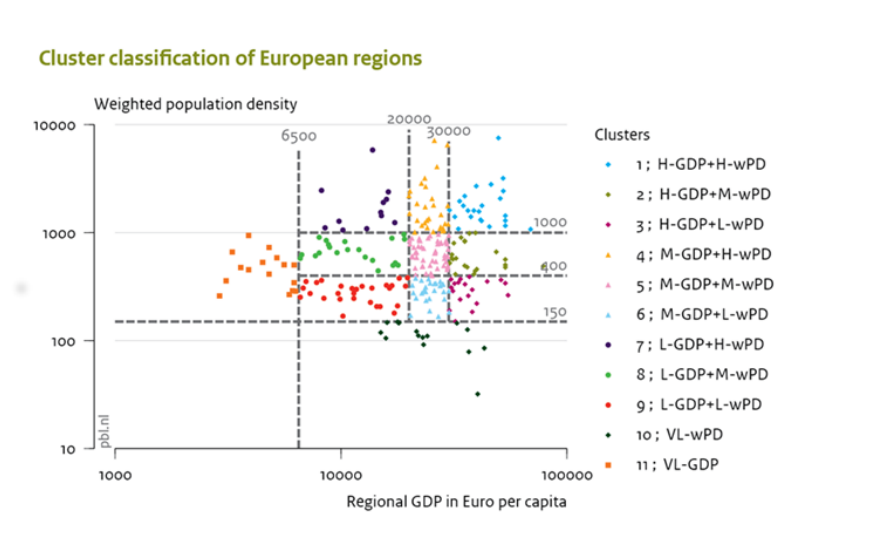
Figure 7: The 11 clusters of regions of Europe classified with their GDP per capita and population